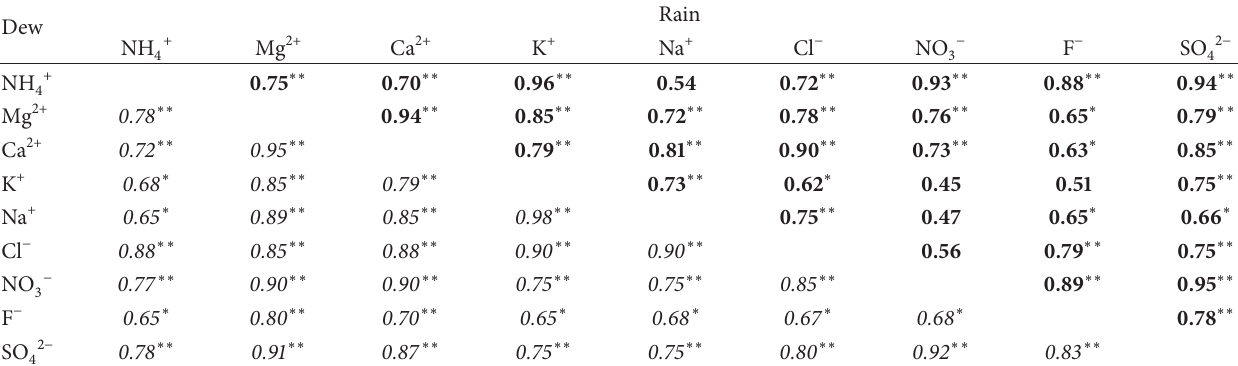
Table 4: Correlation coefficients among ionic constituents in dew water (italic font) and rainwater (bold font).